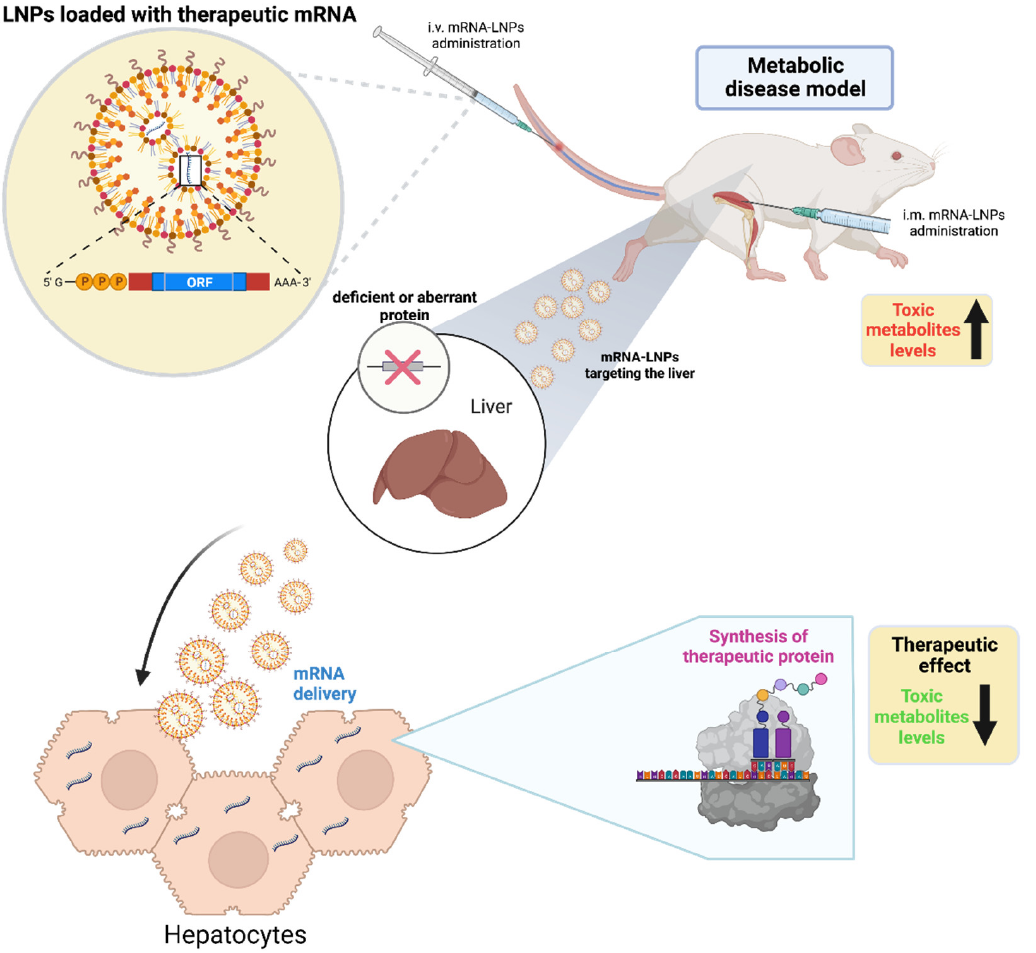
Figure 4. mRNA-based approach for enzyme replacement therapy. In general, mouse models for metabolic disorders from the liver constitute enzyme-deficient mice characterized by the accumulation of toxic serum concentrations of metabolites. mRNA-LNPs inoculated i.m. or i.v. are transported via the bloodstream to the liver where the message is translated, and the protein is synthesized by hepatocytes. Newly produced protein replaces the deficient or aberrant protein associated to the disease resulting in the rescue of metabolic function and fast reduction of toxic metabolite levels, consequently generating a therapeutic effect. Figure was created with biorender.com (accessed on 19 August